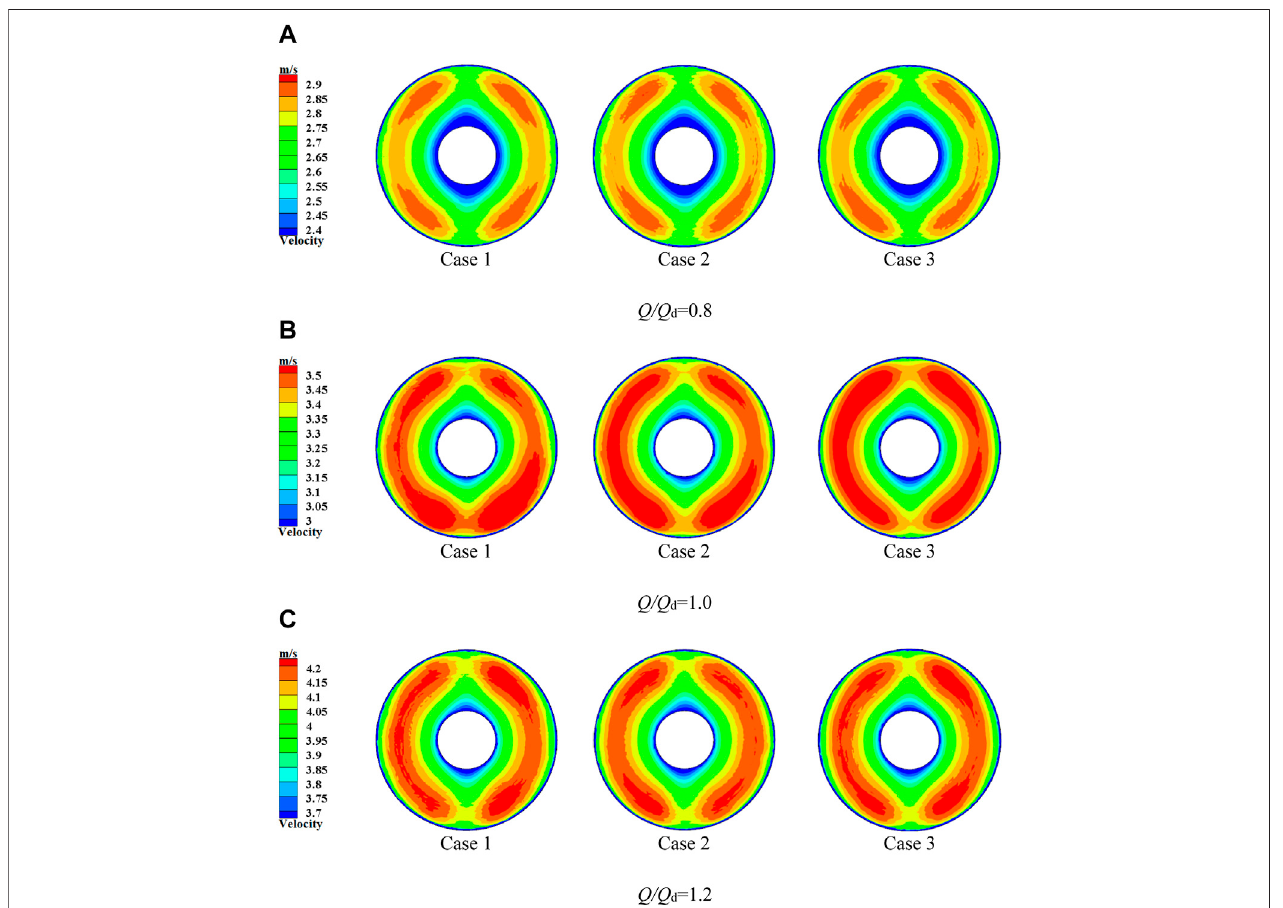
FIGURE 9 | Velocity contours on the outlet of the inlet passage. (A) Q/Q d = 0.8 (B) Q/Q d = 1.0 (C) Q/Q d = 1.2.